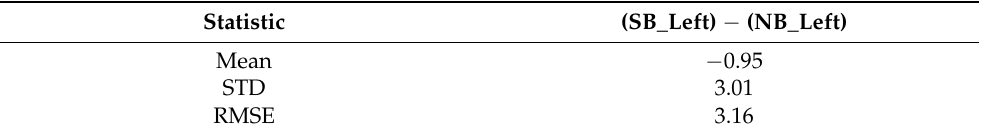
Table 6. Intensity profile difference statistics for NB and SB segments (common lane markings, length: